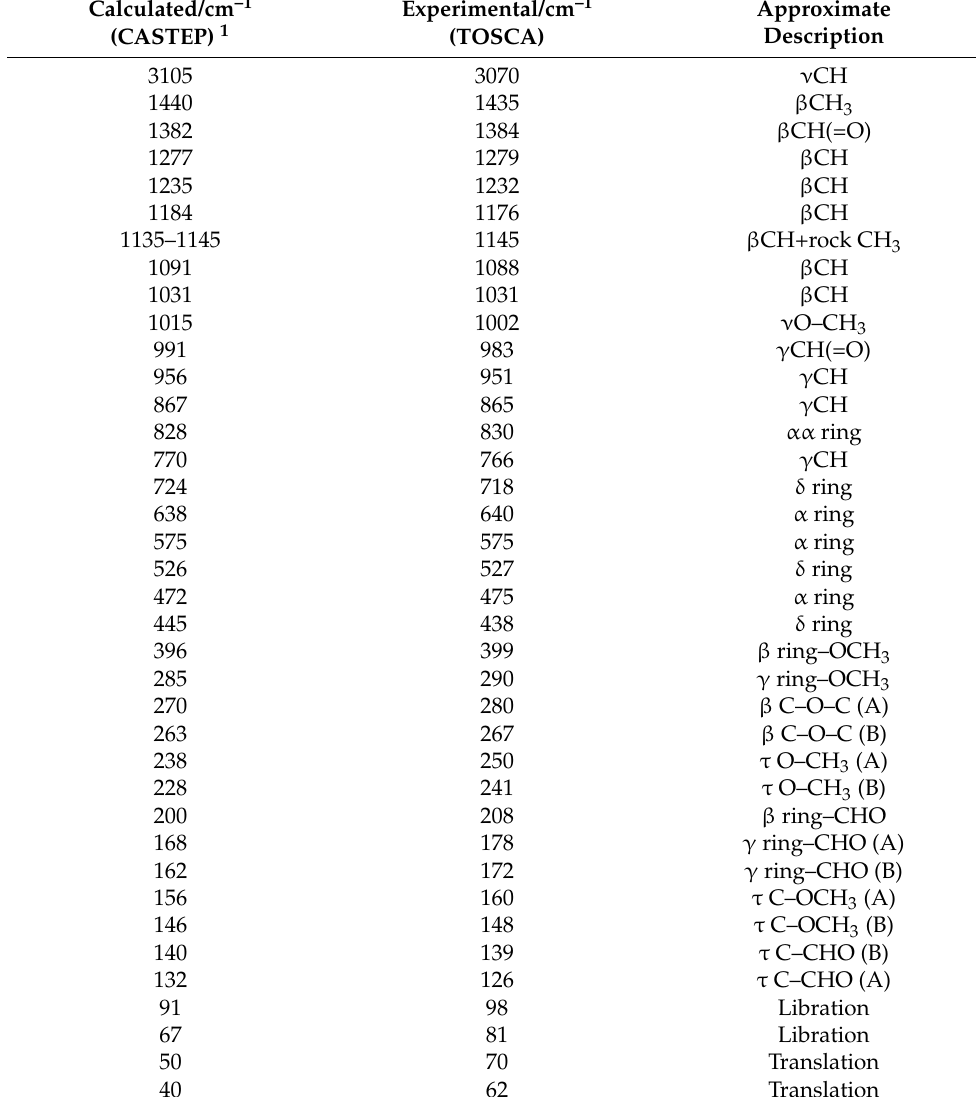
Table 2. Experimental and calculated INS maxima for 2MeOB with mode